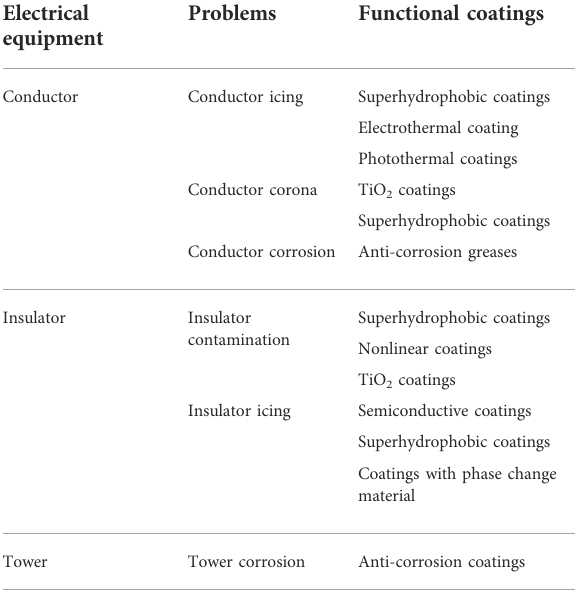
TABLE 1 Representative functional coatings for overhead transmission lines. Electrical